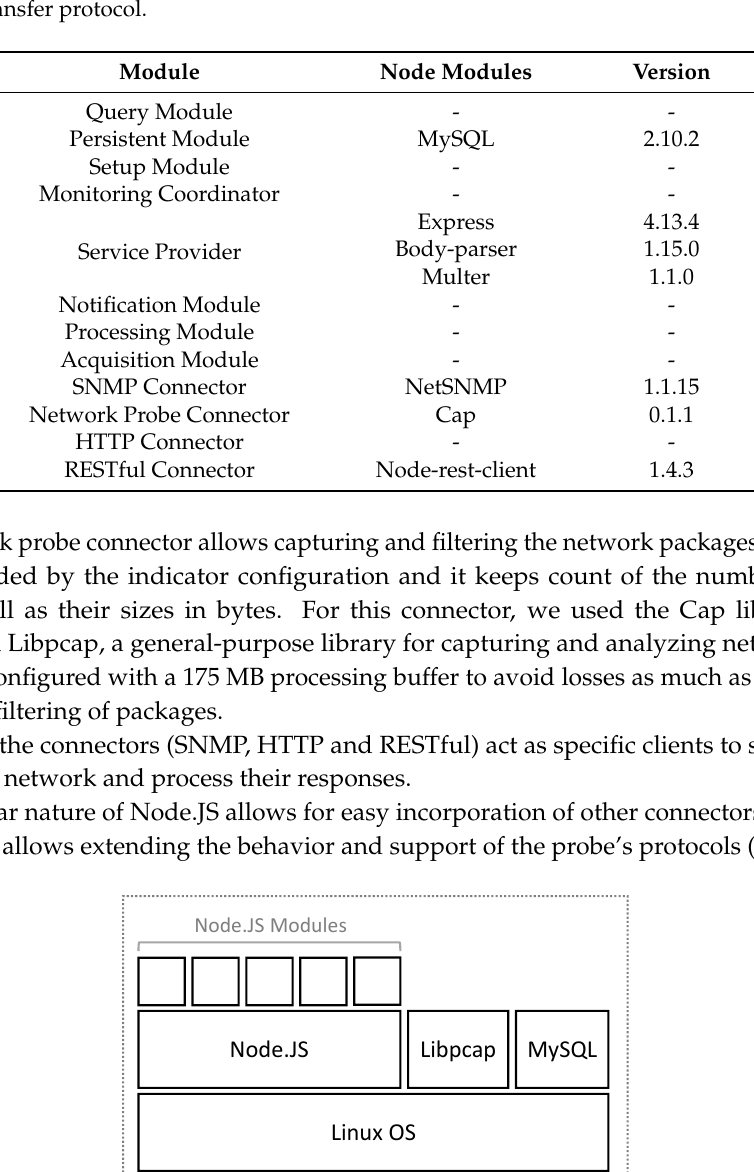
Table 2. Modules of the probe implemented. SNMP: simple network management protocol; and HTTP: hypertext transfer protocol.